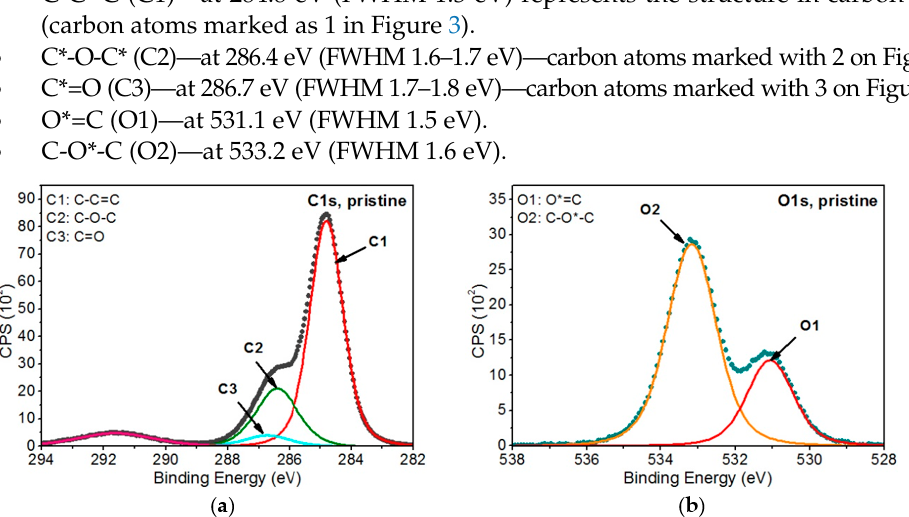
Figure 4. XPS spectra of pristine PEEK: ( a ) C1s band and ( b ) O1s band [35].